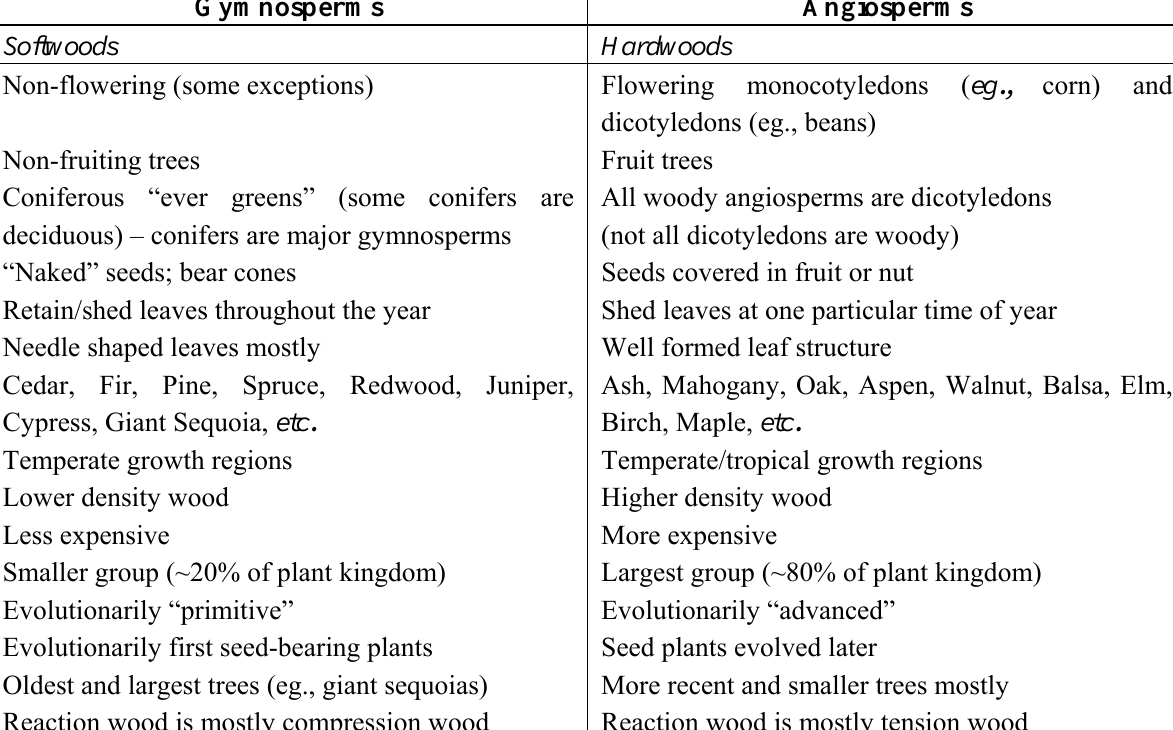
Table 1. Phenotypic properties of Gymnosperms and